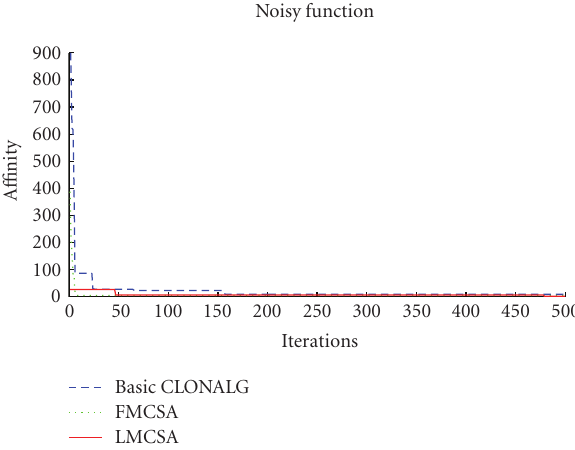
Figure 6: Convergent performances on tablet function ( f 4).